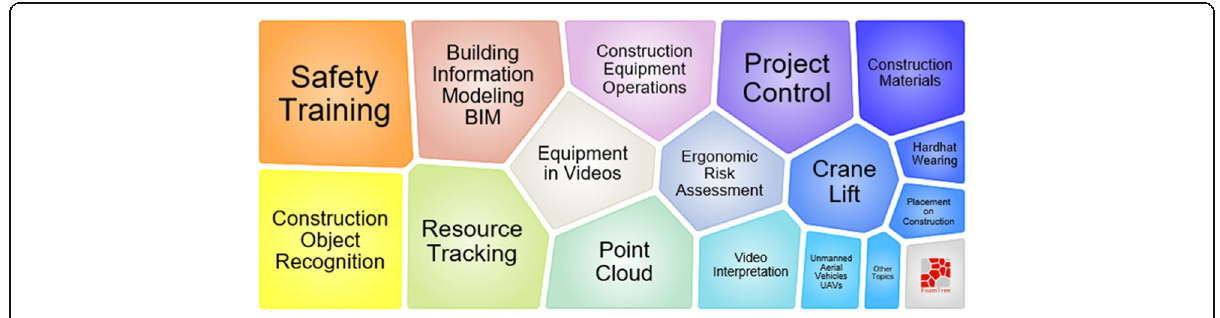
Fig. 12 Foam tree view of keywords in topic